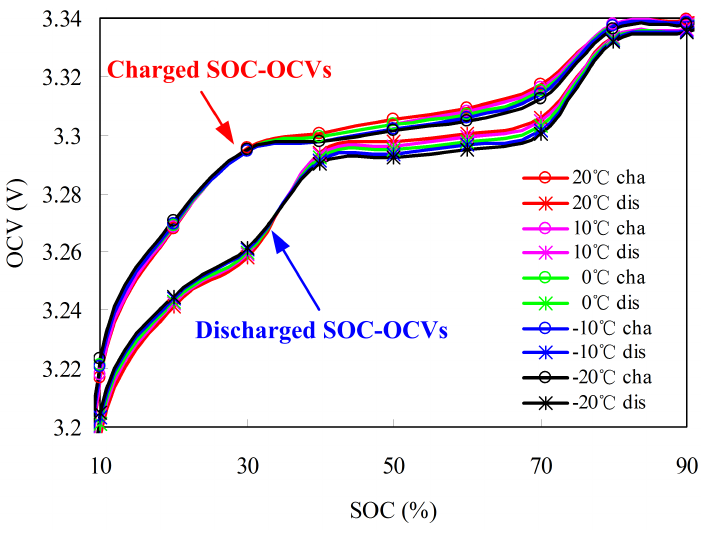
Figure 11. Rated charged and discharged OCV–SOCs at different